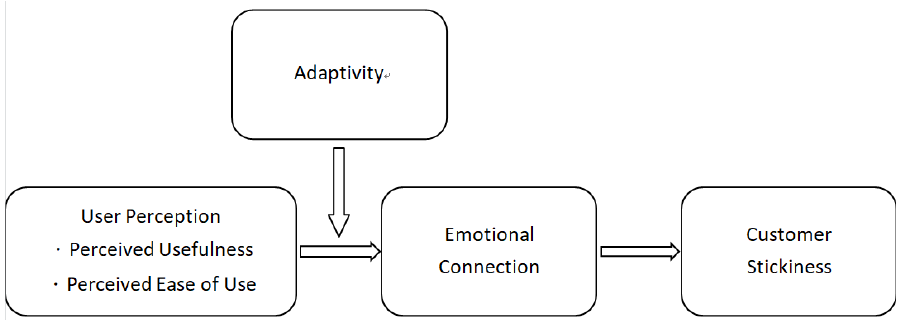
Figure 1. Theoretical framework.